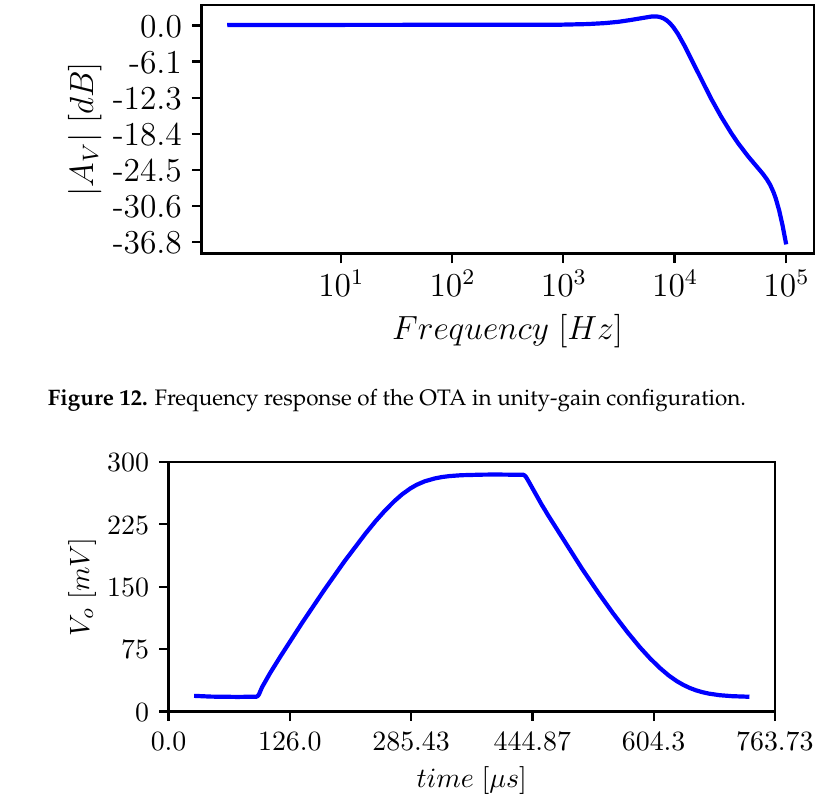
Figure 13. Transient response to a 15–285 mV input